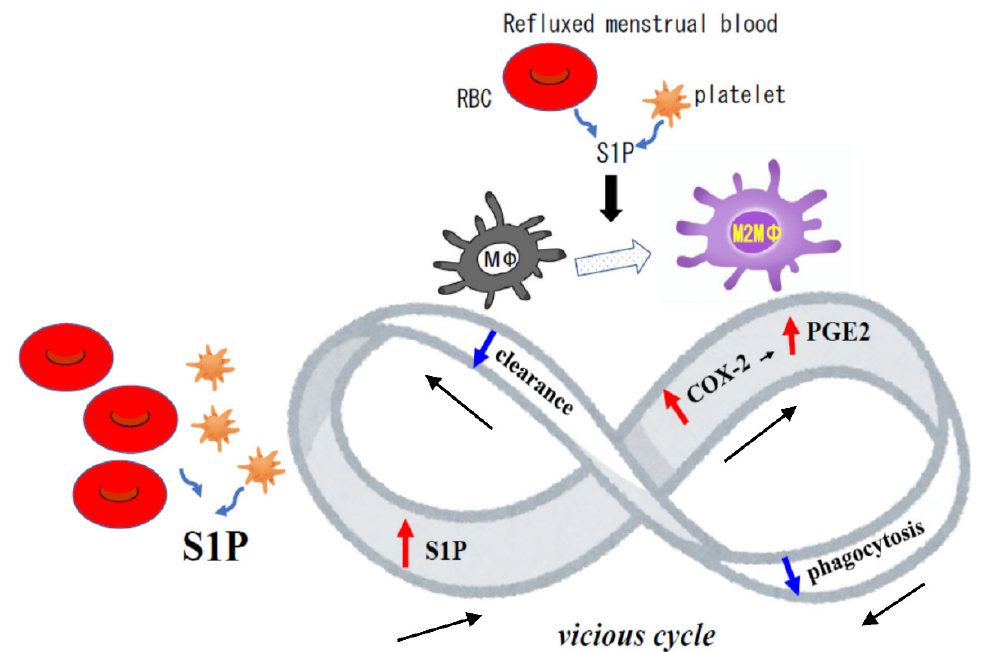
Figure 5. Schema of the hypothesis: a vicious cycle. S1P, which is rich in red blood cells (RBC) and platelets, skewed M2 macrophages (M Φ ), and induced COX-2 expression in the peritoneal M Φ . Decreased phagocytosis of M Φ caused by increased prostaglandin (PG)-E2 [23] may suppress its effect of clearance of peritoneal cavity, resulting in a higher level of S1P concentration in the peritoneal cavity. Further increase in S1P in the peritoneal cavity may induce more COX-2 expression, followed by a further decrease in phagocytosis of M Φ .